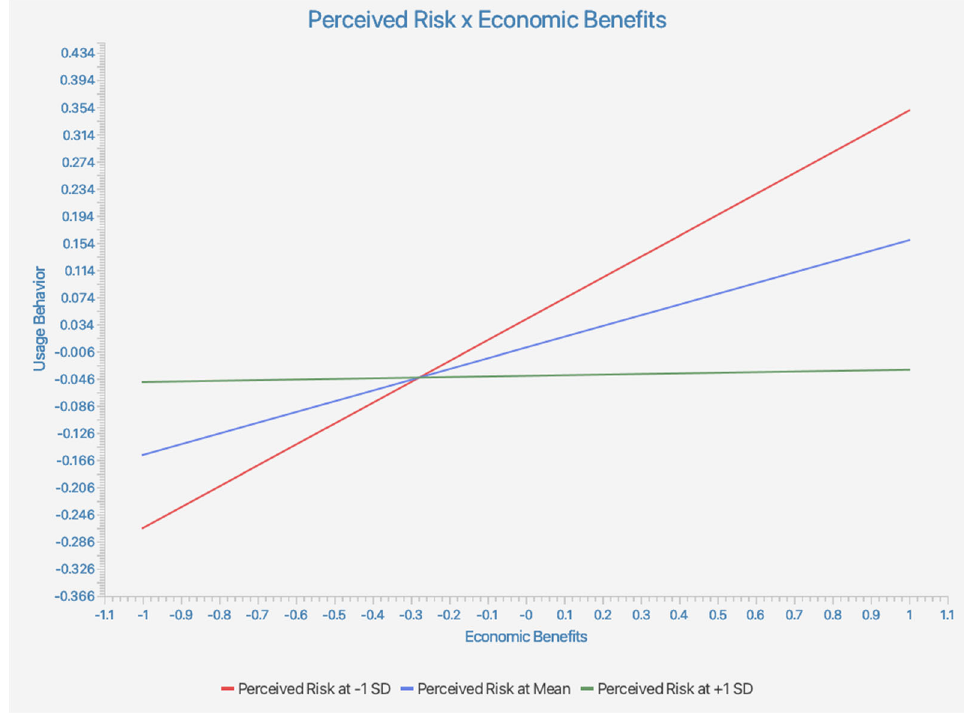
Figure 2. The moderating effect of perceived risk on the relationship between economic benefits and usage behavior.